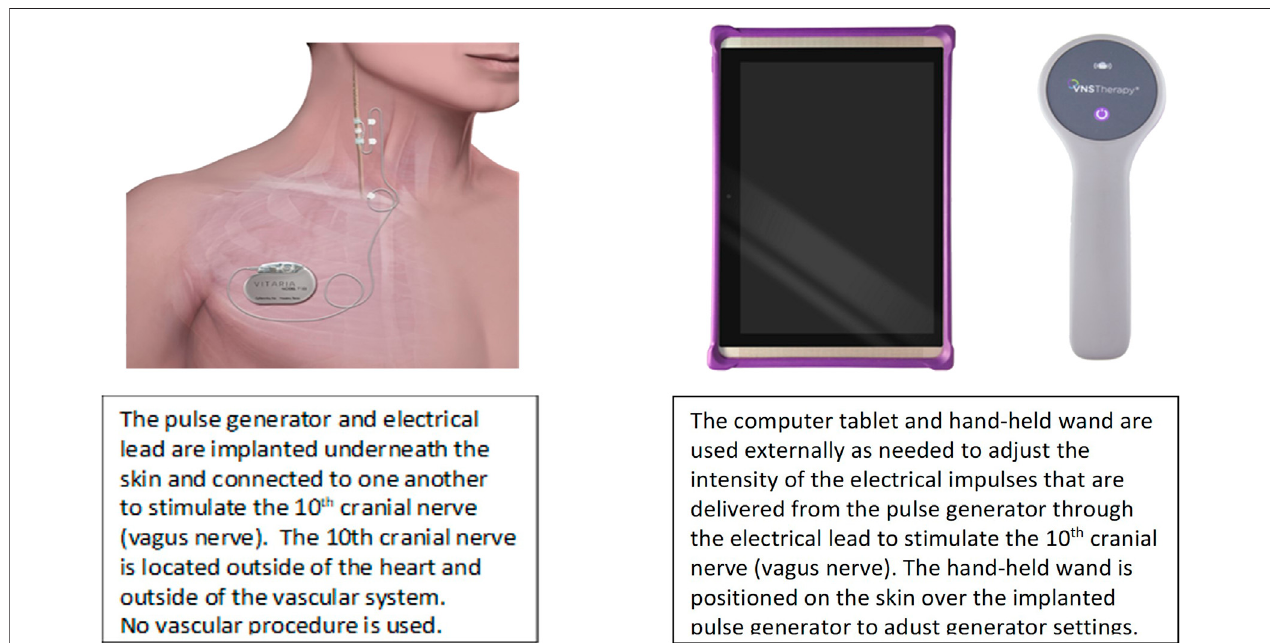
FIGURE 2 | VNS system to deliver ART. Adapted from Anand IS, et al. ESC Heart Fail 2020 with permission.